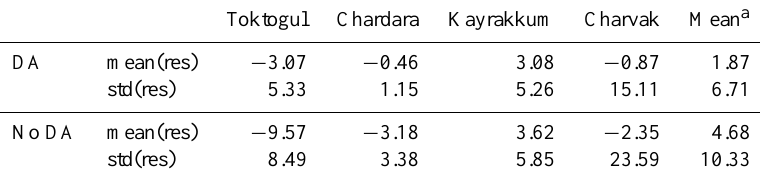
Table 6. Reservoir water level residuals with and without assimilation of radar altimetry data. All numbers are given in